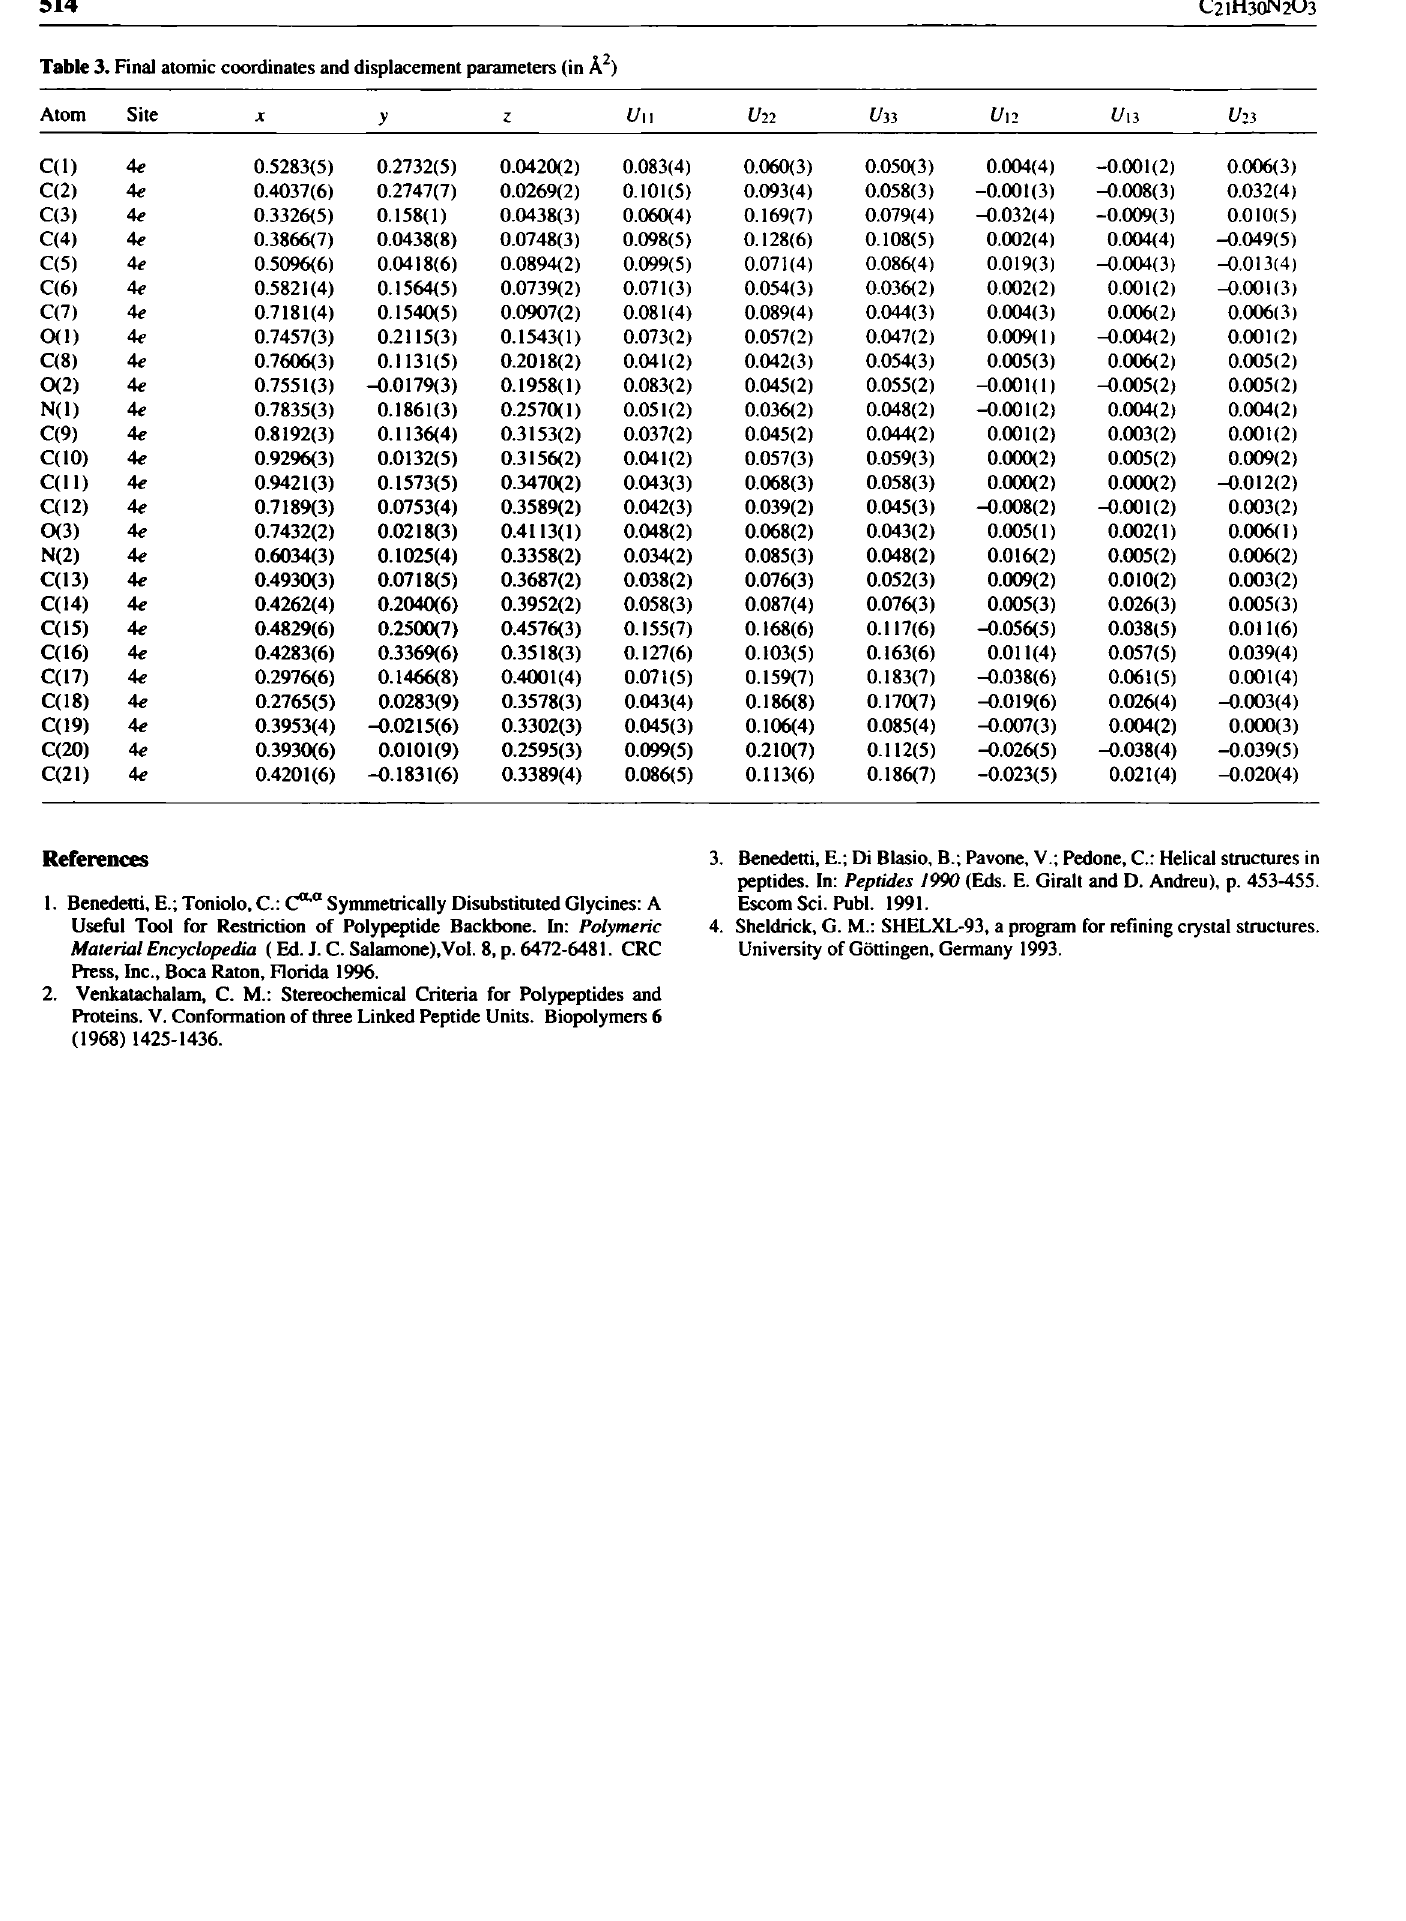
Table 3. Final atomic coordinates and displacement parameters (in